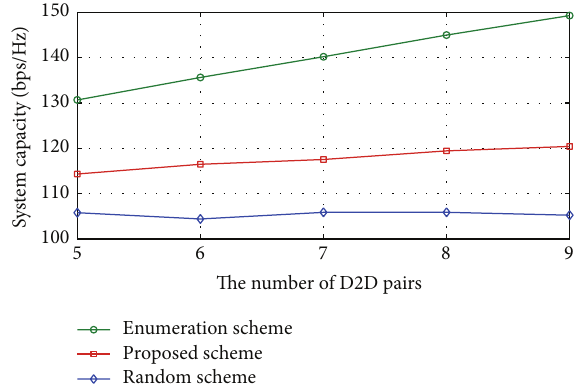
Figure 4: System capacity with the number of D2D pairs.